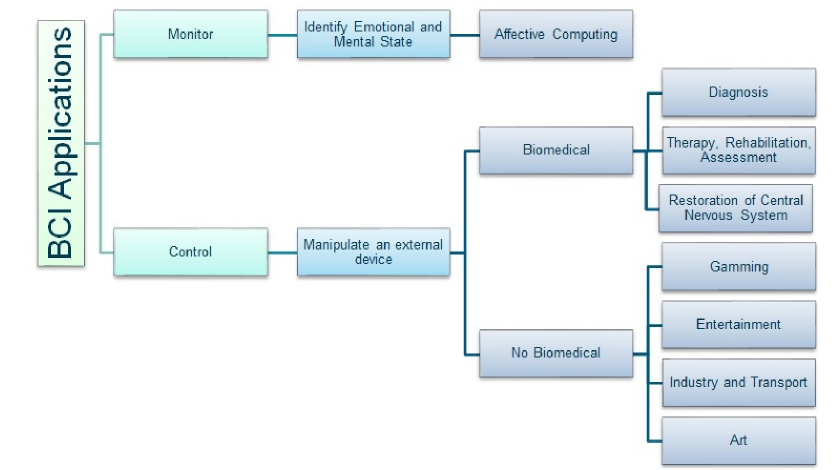
Figure 10. BCI applications by their final